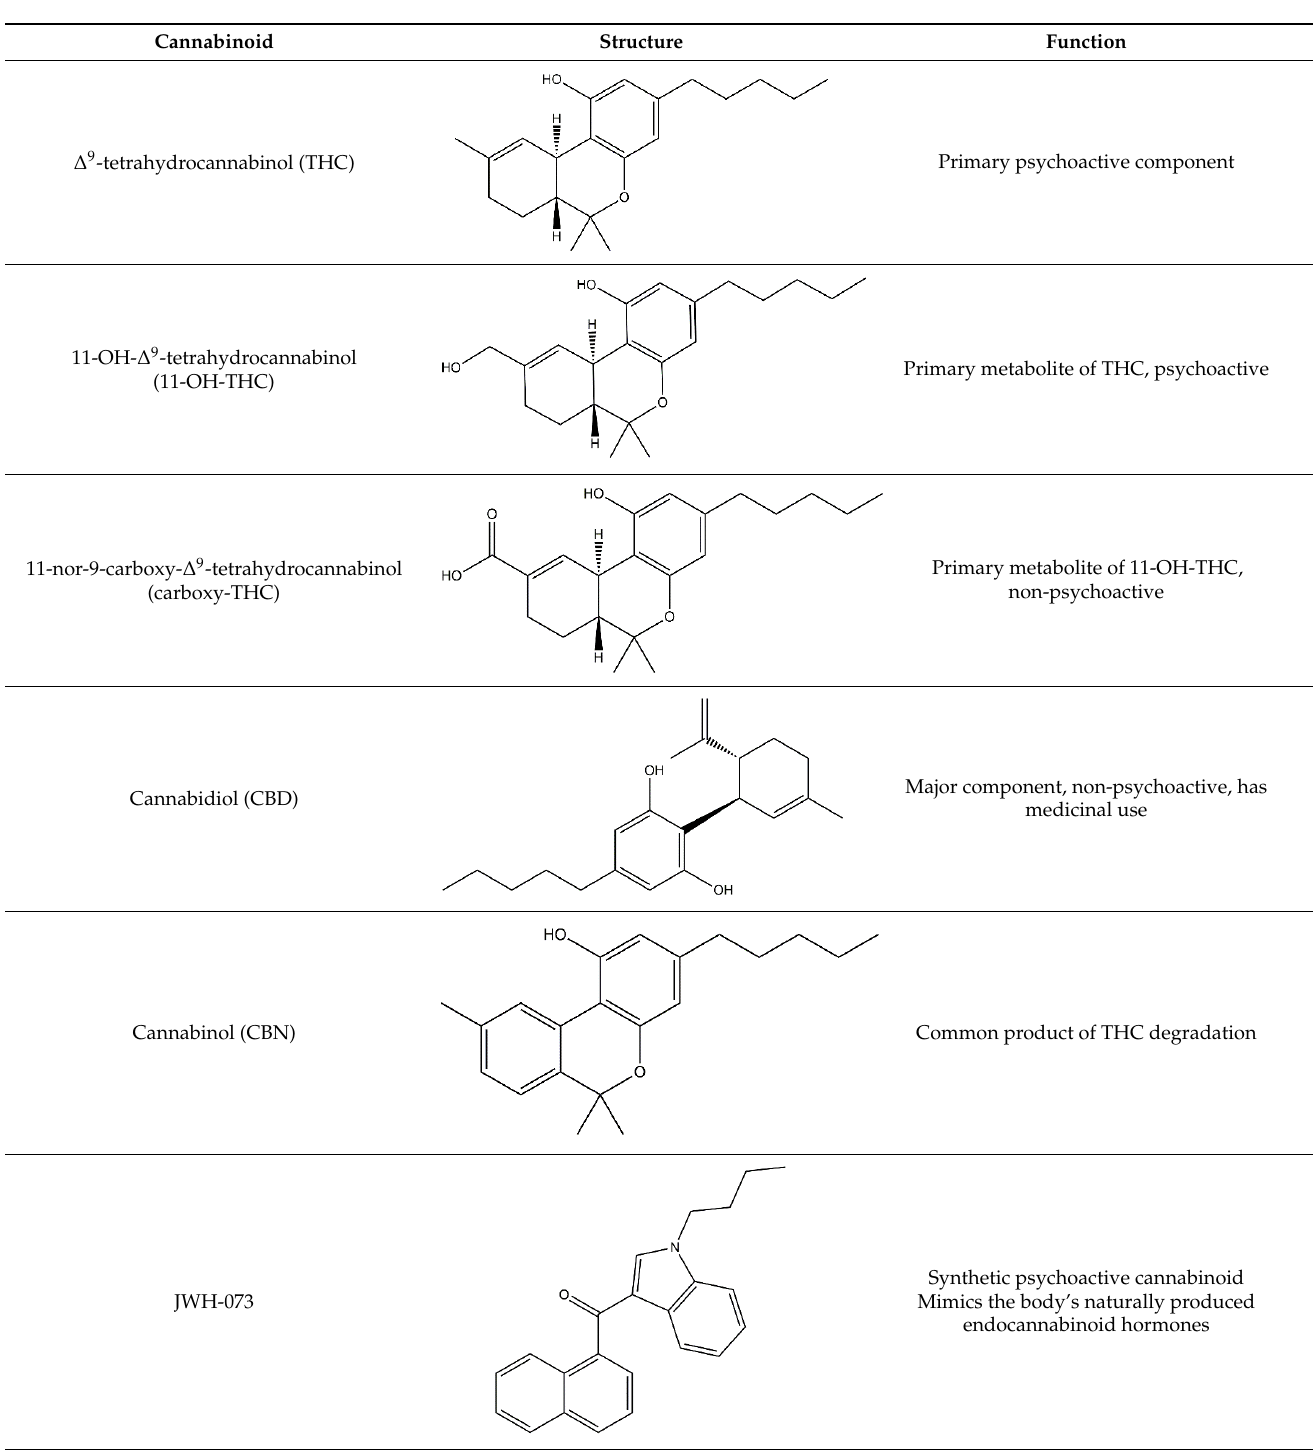
Table 1. Chemical structures and main functions of most relevant cannabinoids. Adapted with permission of [32]. Copyright (2020) American Chemical